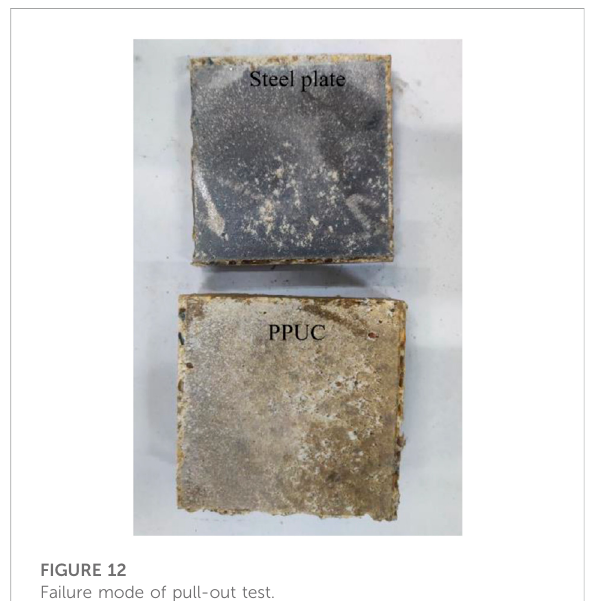
FIGURE 12 Failure mode of pull-out